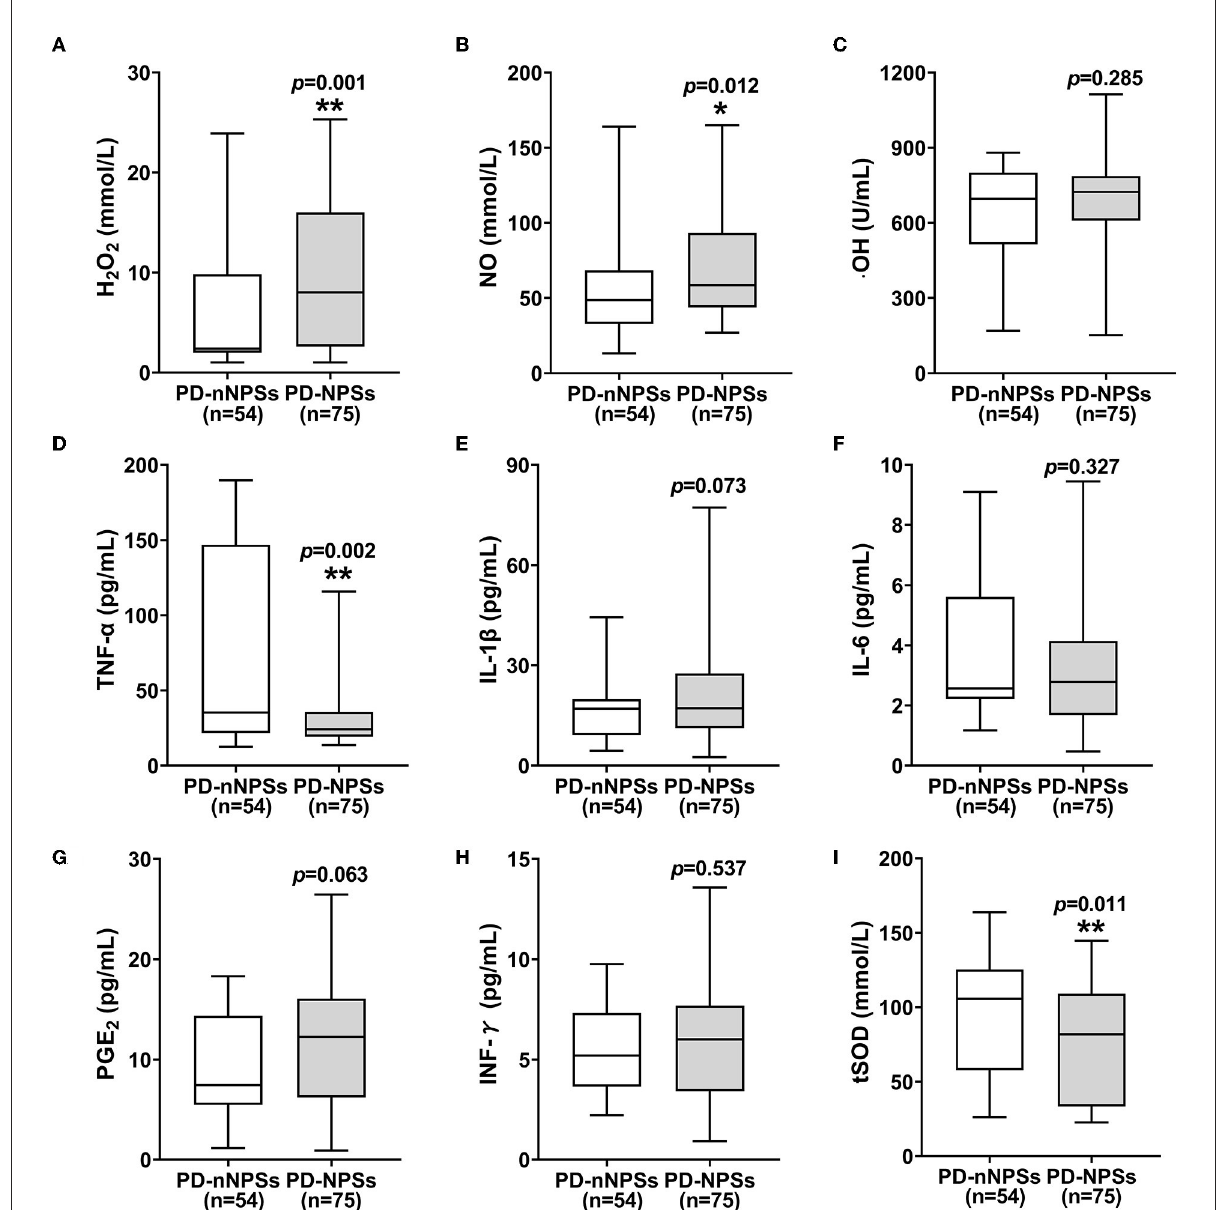
FIGURE1 (A–I) The levels of free radicals and neuroinflammatory factors and the activity of tSOD in CSF were compared between PD-NPSs group and PD-nNPSs group. The results suggested that the levels of H 2 O 2 and NO in CSF were significantly elevated, and the activity of tSOD was significantly reduced in CSF from PD-NPSs group compared to that from PD-nNPSs group.